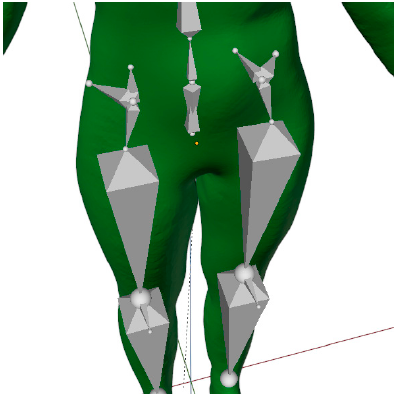
Figure 2. Blender 3D—improved armature of the lower part of the kinematic 3D body model.